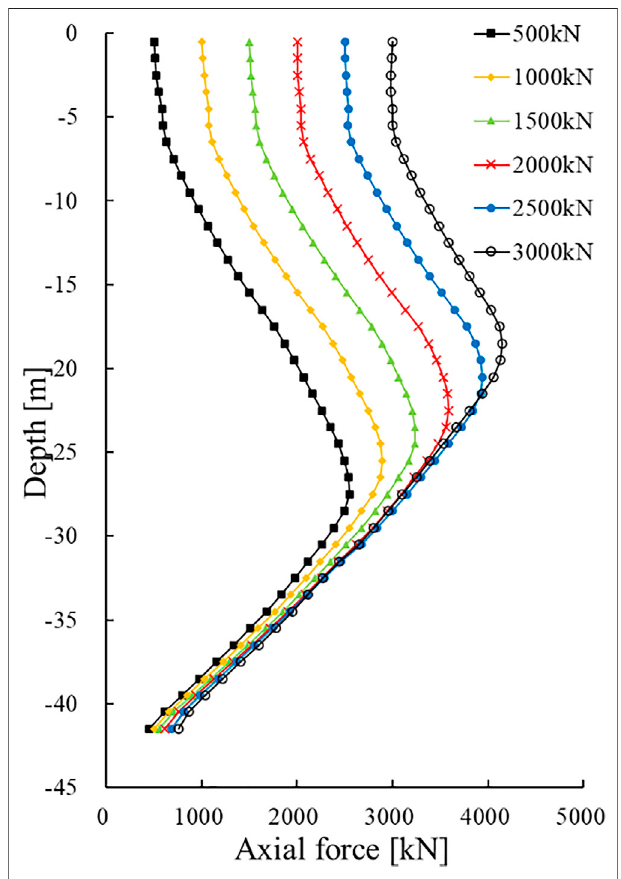
FIGURE 10 | Distribution of axial forces on PHC pile determined under various working loads.